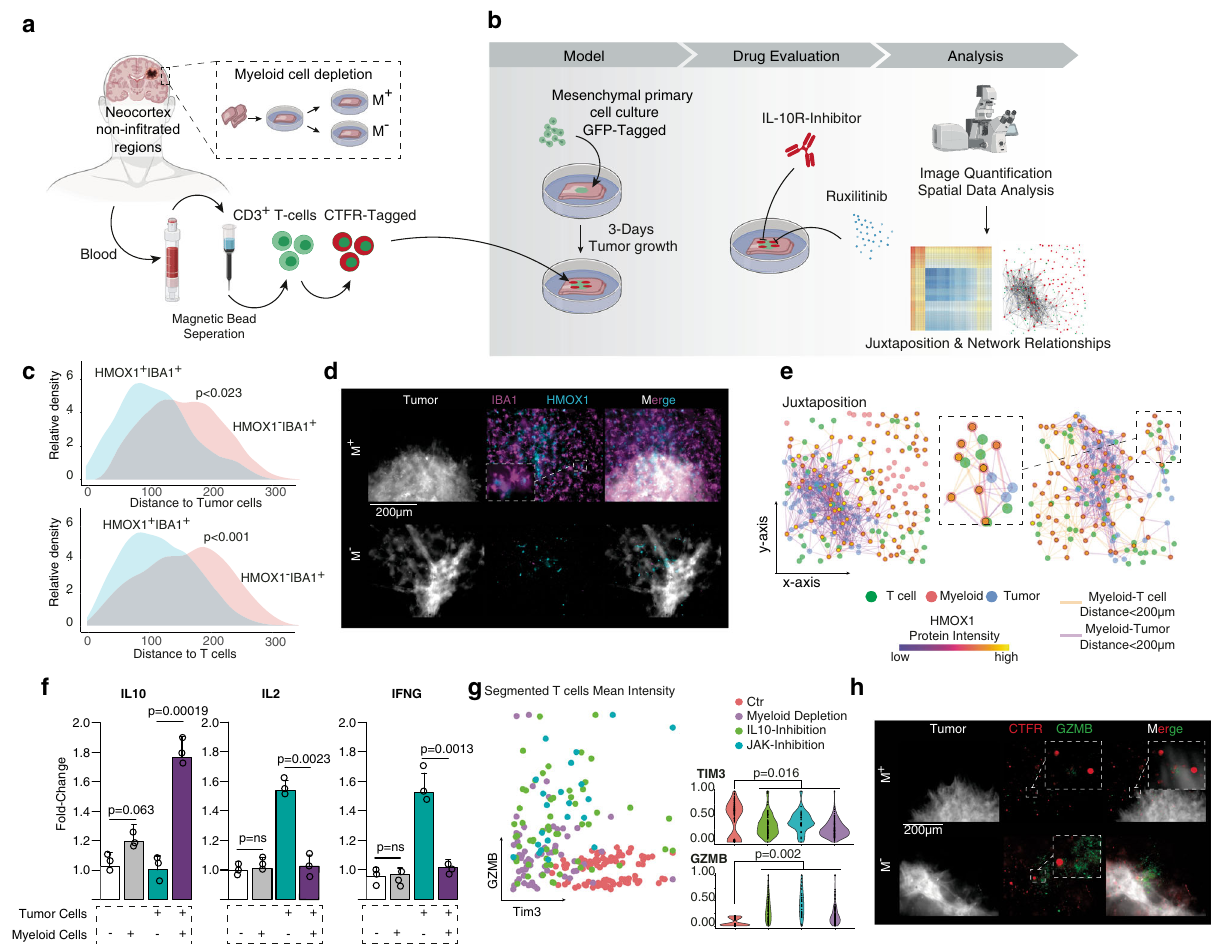
Fig. 6 Functional modeling of T cell response in human brain slices. a , b Illustration of the work fl ow using neocortical slice cultures. c Density plots to quantify the spatial distance between HMOX + and HMOX − IBA1 + myeloid cells and tumor (upper plot) and T cells (bottom). P values are determined by non-paired t- test statistics after proving the normal distribution. d Immunostainings of IBA1 (Macrophages and Microglia) in magenta and HMOX1 in cyan, tumor cells are depicted in gray. In the upper panel, the control set with no myeloid cell depletion (M + ) is shown, the bottom panel contains the myeloid cell-depleted sections. The experiments and stainings were repeated at least six times for each condition. e Two examples of the reconstruction of cellular relationships. Each point represents a cell as indicated by the legend at the bottom. Lines in orange represent a myeloid-T cell connection (with a distance lower than 100 µ m). Tumor-myeloid relationships are illustrated in purple (with a distance lower than 100 µ m). The dots of the connected myeloid cells show the expression of HMOX1 by the inner color fi lling. f ELISA measurements of IL-10 and IL-2. P values are determined by one-way ANOVA ( c , e , f , j ) adjusted by Benjamini – Hochberg ( c , e, f, j ) for multiple testing. Data were given as mean ± standard deviation. g Scatterplot of GZMB (y-axis) versus TIM3 protein level (x-axis). Each dot represents a segmented T cell from different experimental conditions as indicated by the legend at the right. Right part: A quanti fi cation of the data. P values are determined by one-way ANOVA. h Immunostainings of T cells (CSFE-Tagged, in red) and GZMB, a marker of T cell activation (green). The experiments and stainings were repeated at least six times for each